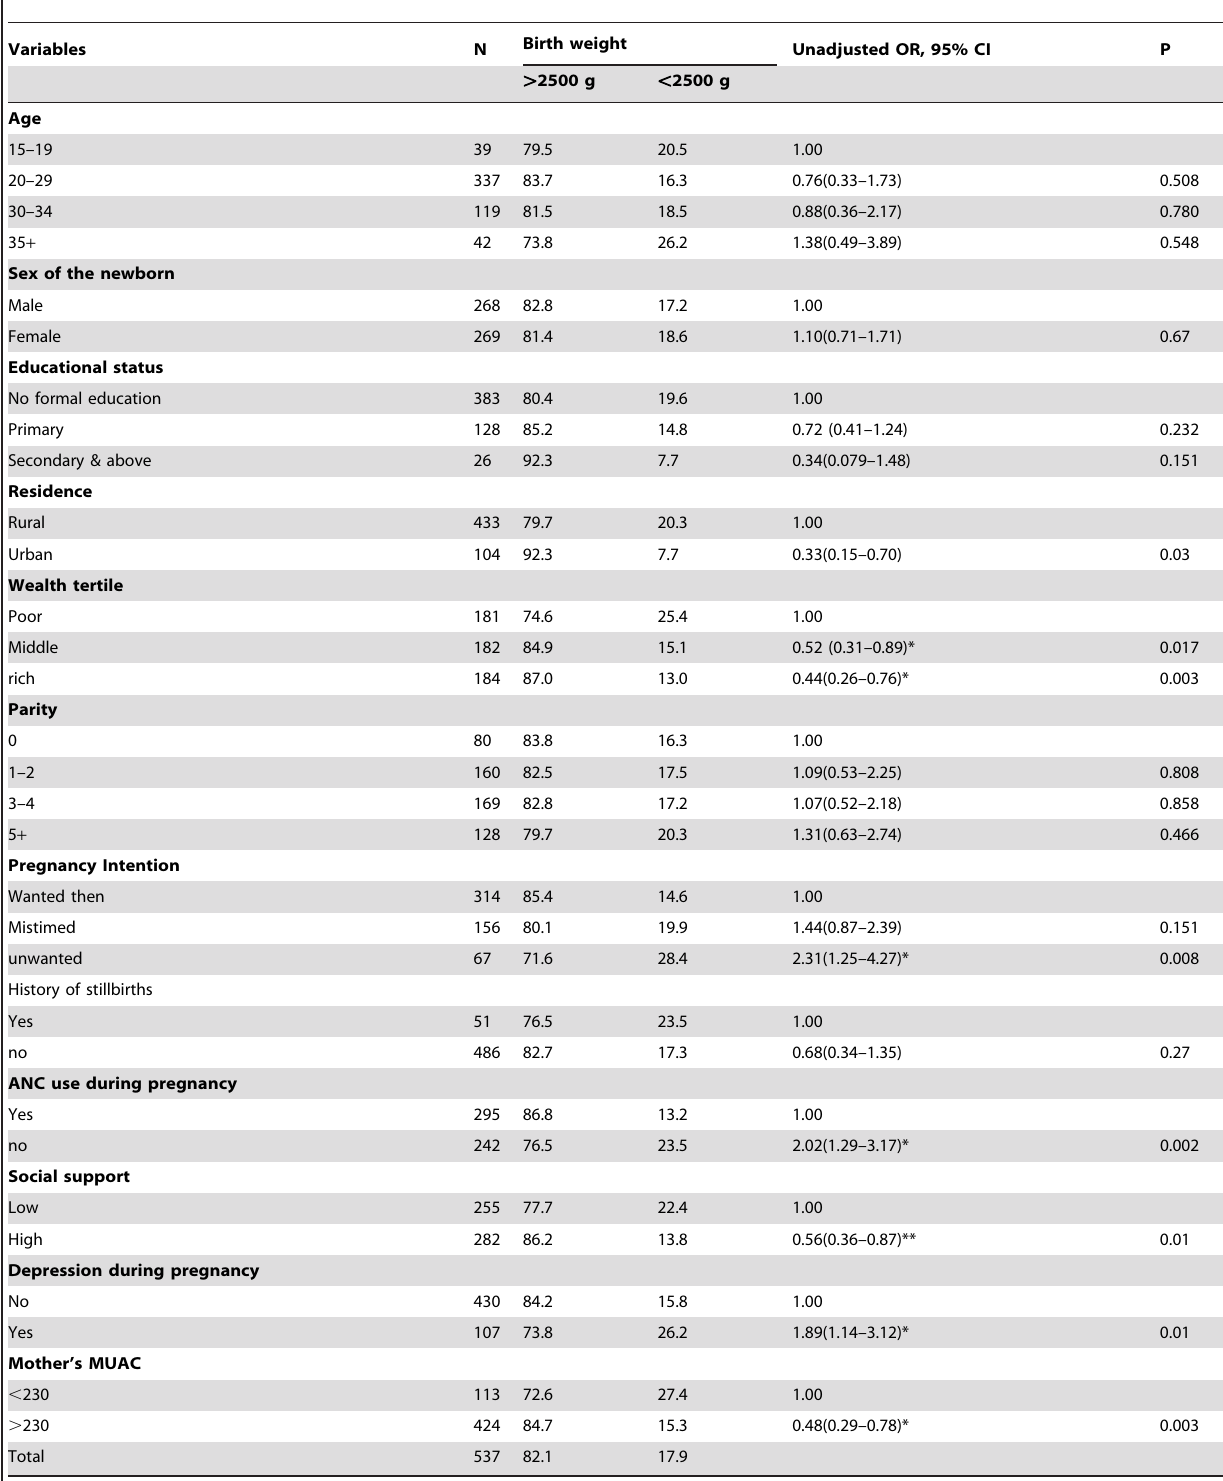
Table 1. Low birth weight by socio-demographic factors, pregnancy intention and antenatal depression, southwest Ethiopia,